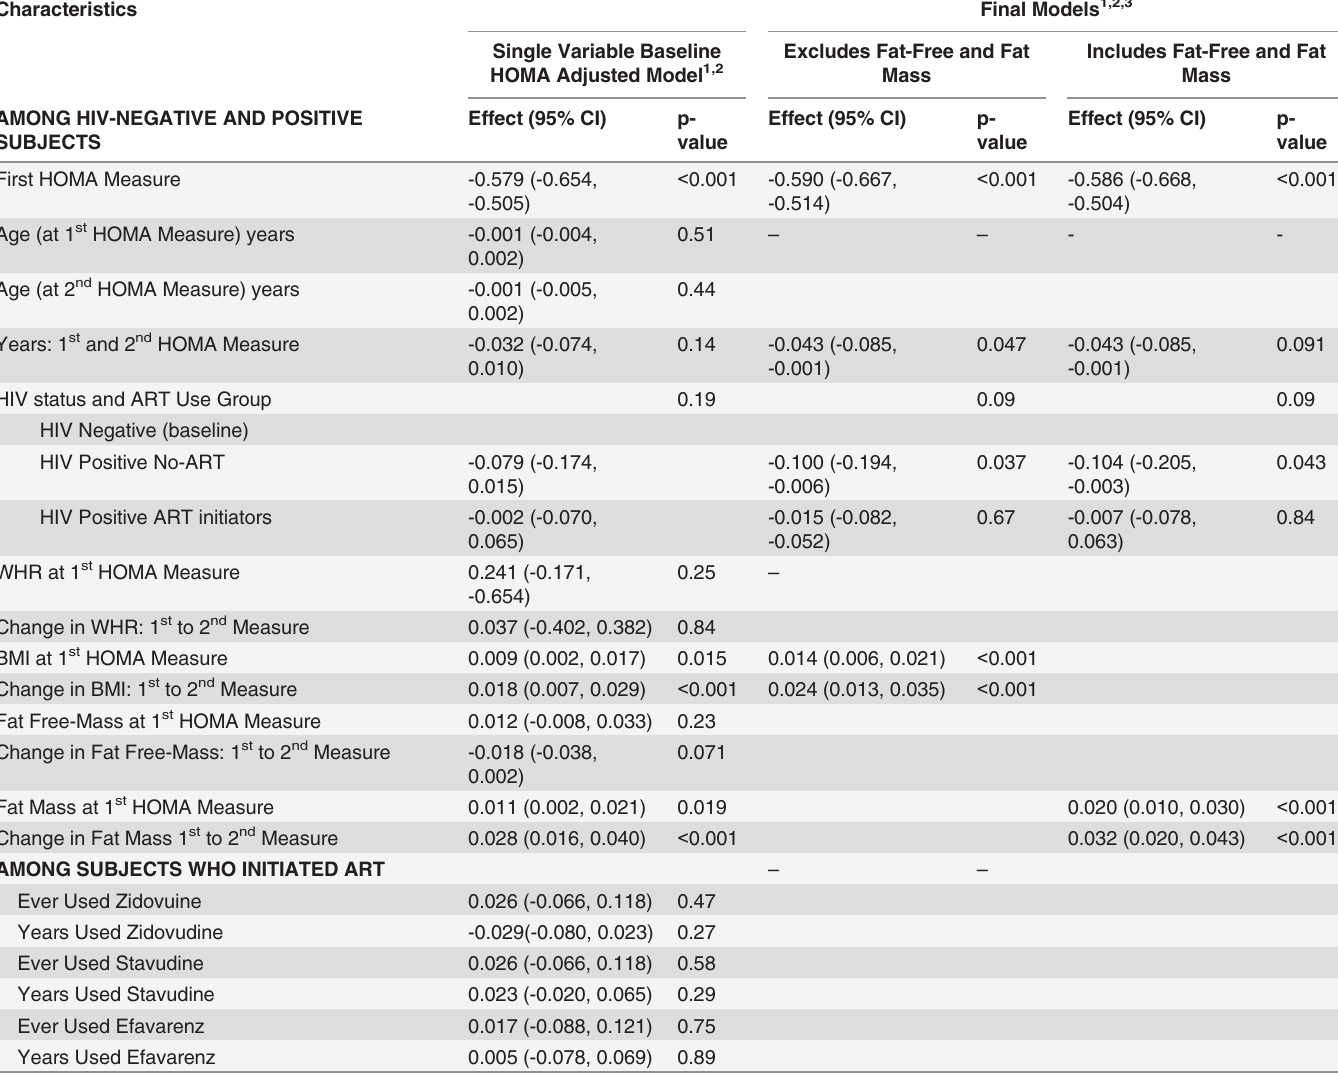
Table 3. Unadjusted and adjusted predictors of change in Log 10- HOMA from first to second measure from ANCOVA Models 1 , 2 .